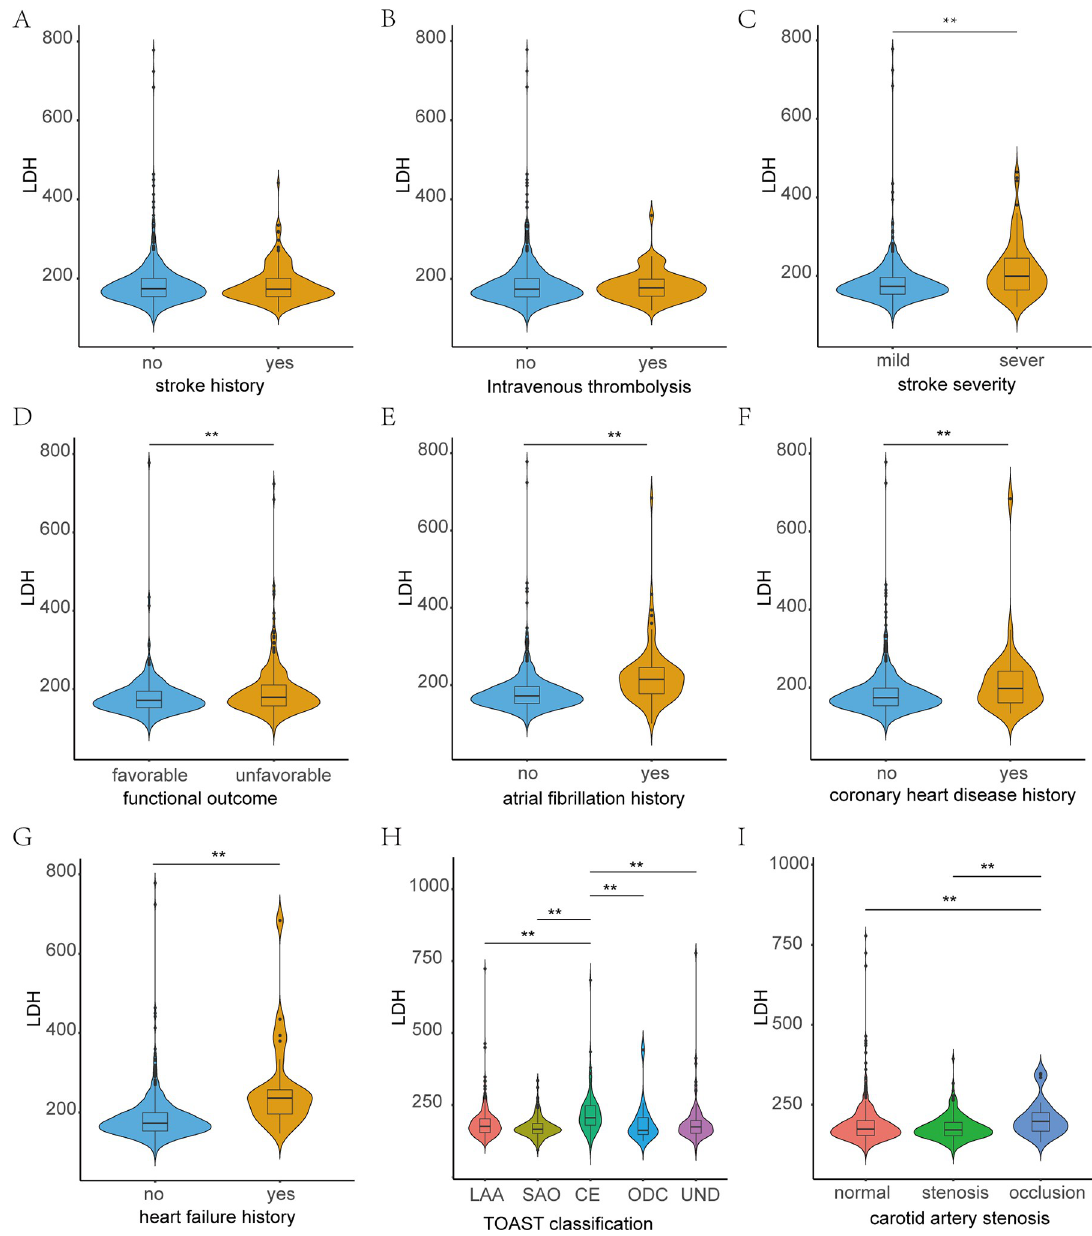
Fig 2. Comparisons of admission LDH levels according to stroke history (A), intravenous thrombolysis (B), stroke severity (C), functional outcome (D), atrial fibrillation (E), coronaty heart disease history (F), heart failure history (G), TOSAT classification (H) and carotid artery stenosis(I) in AIS patients. LAA, Large-artery atherosclerosis; CE, Cardioembolism; SAO, Small-vessel occlusion; ODC, Other determined etiology; UND, Undetermined etiology. � : P < 0.05; �� : P <